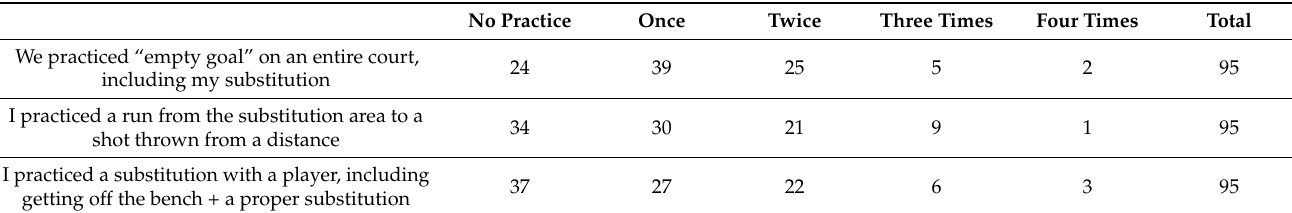
Table 2. Goalkeeper responses regarding the number of weekly